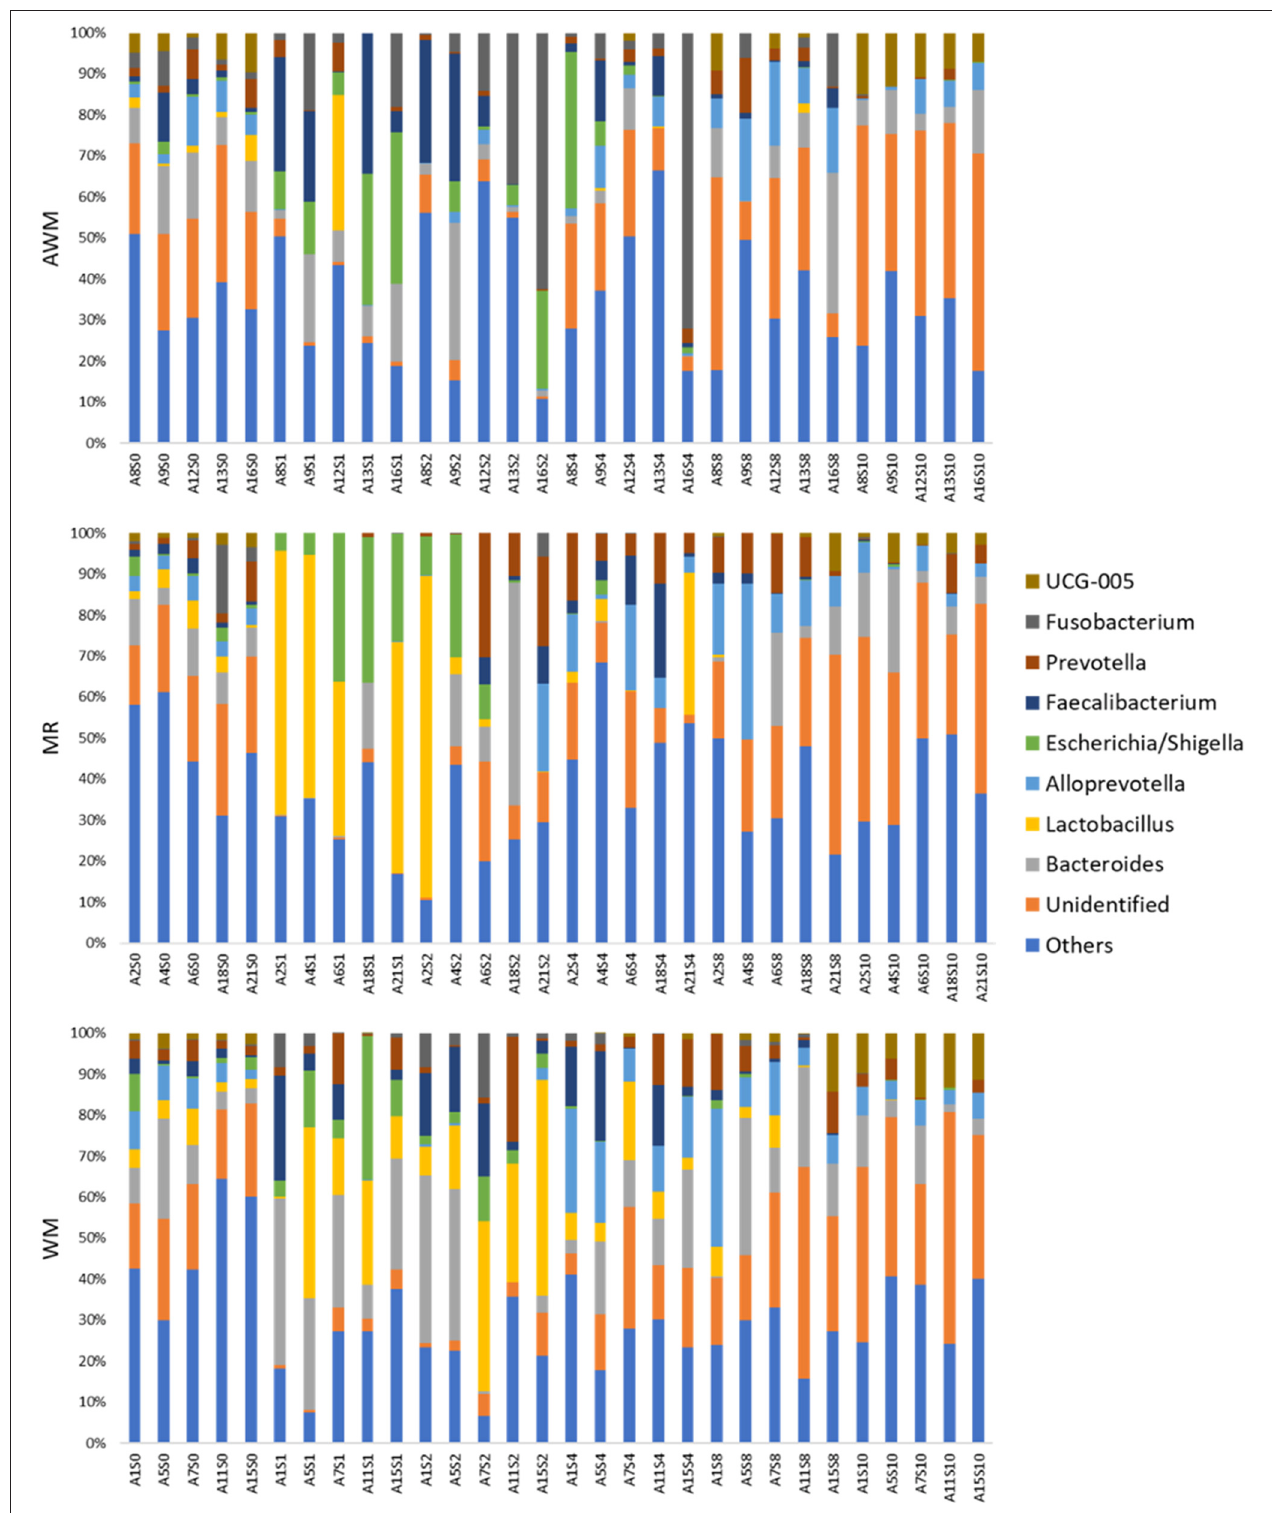
FIGURE 6 | Bacterial relative abundance for the genus level in fecal samples in dairy calves fed different liquid diets. Each bar represents the identification of the analyzed sample: Axx-Sy, where Axx is the animal, Sy, the week in which the collection was performed. AWM, Acidified milk; MR, Milk Replacer; WM, Whole milk.